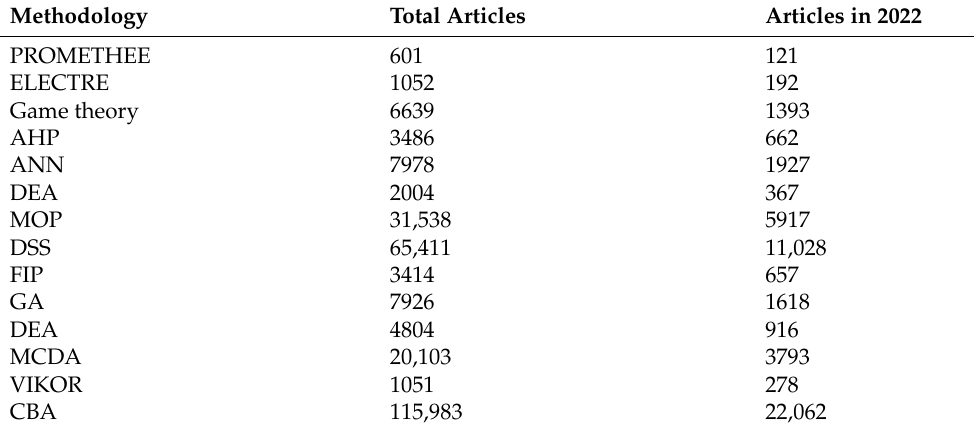
Table 3. Number of papers based on a particular type of methodology (2010 to >2022) (accessed on 15 December